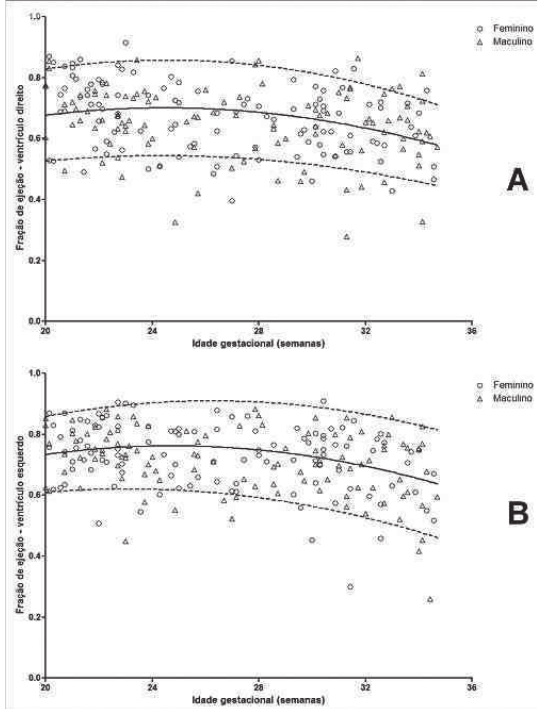
Fig. 2 - Curvas de referência - 5, 50 e 95 percentil – para a fração de ejeção: A) Ventrículo direito; B) Ventrículo esquerdo. Os percentis foram avaliados como sugerido por Altman & Chitty [24], usando dados de ambos os fetos, masculinos